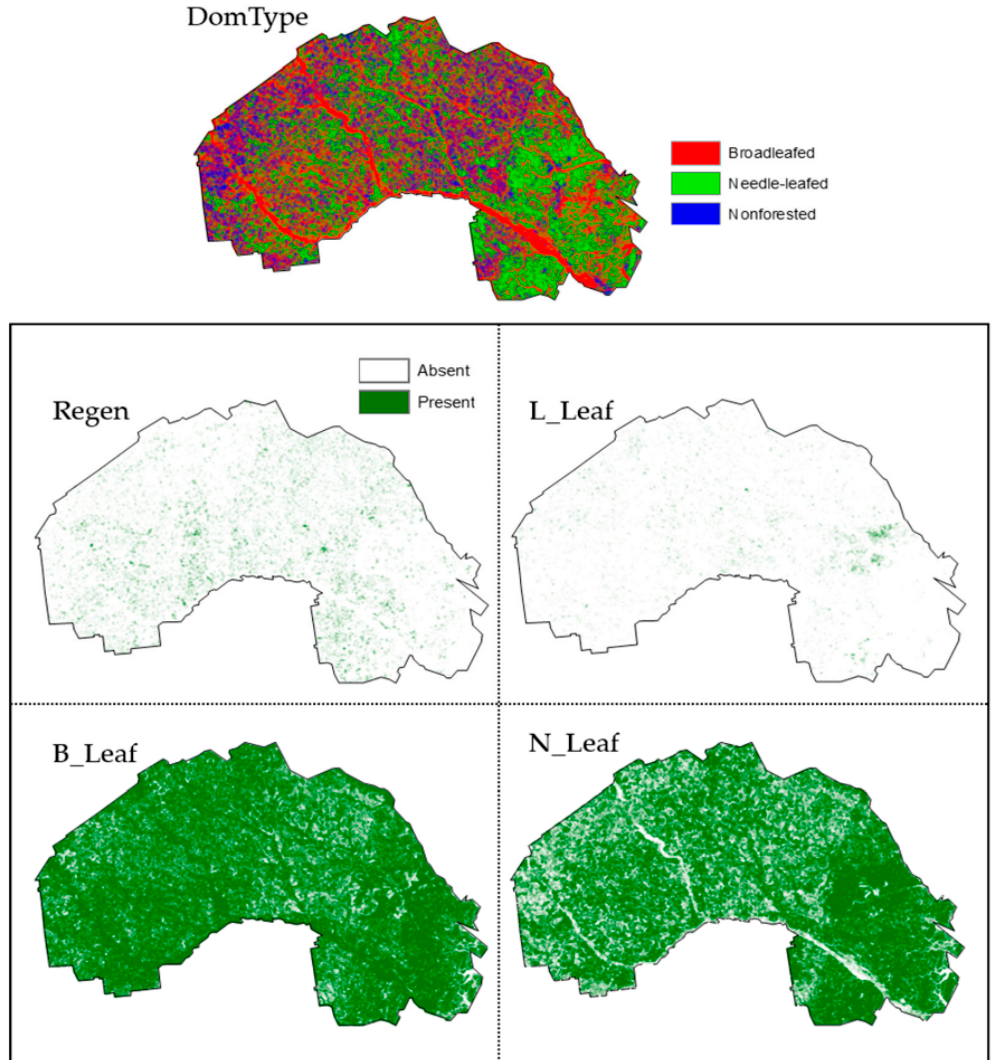
Figure A3. L1 Dominant forest type (DomType) and presence / absence hard classification raster surfaces for areas containing longleaf pine trees (L_Leaf), areas composed of mostly regeneration (Regen), areas containing needle-leaf trees (N-Leaf) and areas contain broadleaf trees within the Fort Stewart SGA. L1 probability surfaces and a most likely class (MLC) rule were used to create each hard classification. Hard classification map accuracies can be found in Figure 6.